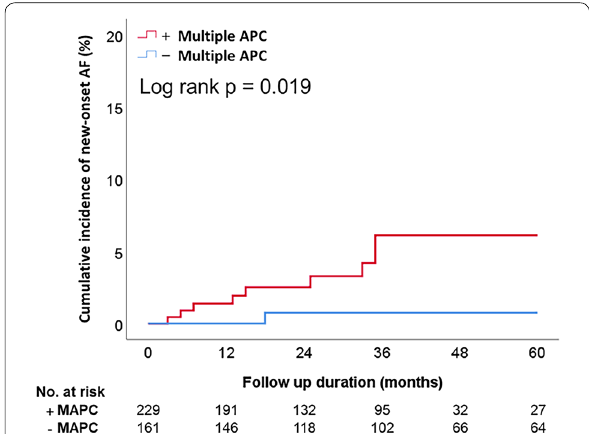
Fig. 2 Cumulative incidence of new‑onset atrial